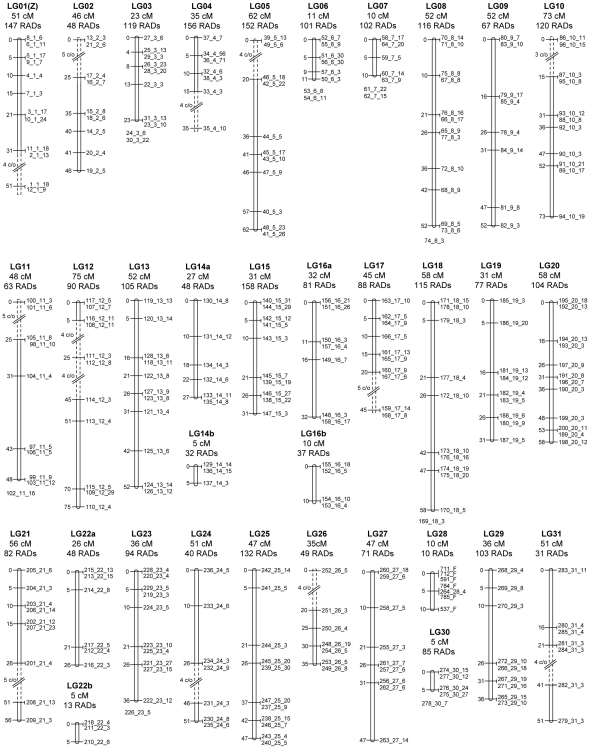
Linkage map of the Plutella xylostella (n = 31) genome.This was inferred from 2,878 RAD alleles collapsed into 285 discrete RAD markers. Each linkage group contains between 10 and 158 RAD alleles (labelled RADs) and the total map length is 1,292 cM. Each RAD marker is labelled with three numbers (i_ii_iii) corresponding to (i) the RAD marker (1–285), (ii) the chromosome number (1–31) and (iii) the number of RAD alleles at that marker. Linkage groups 1–28 are homologous to the B. mori (n = 28) chromosome numbering system, and LG29, LG30 and LG31 represent fusions to chromosomes 11, 23 and 24 respectively in B. mori. Dashed lines represent manual linkages inferred from 3, 4 or 5 genotype differences that were otherwise left ungrouped due to small sample size. As 20 progeny were used to construct the map, distances were approximated as 5 cM (1/20) per 1 crossing-over (c/o) event. On chromosomes 14, 16 and 22, markers formed two distinct groups and may be separated by regions of high recombination rates or chromosomal assignment error. In total, 11 of the 285 RAD markers could not be confidently assigned to their predicted chromosome. Linkage group 28 contained only four RAD markers at a single locus. Six additional markers were identified for this chromosome using JoinMap 3.0, from the remaining paternal markers not assigned to linkage groups.